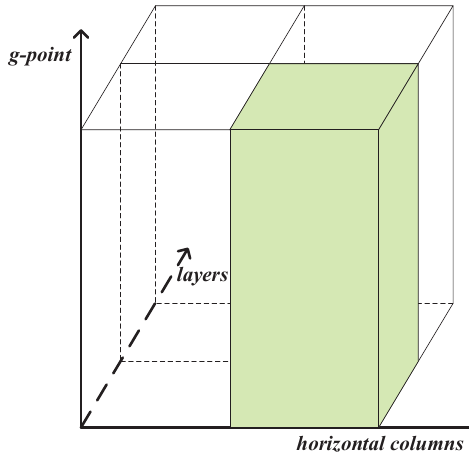
Figure 4. Schematic diagram of 2-D decomposition for the RRTMG_LW in the GPU